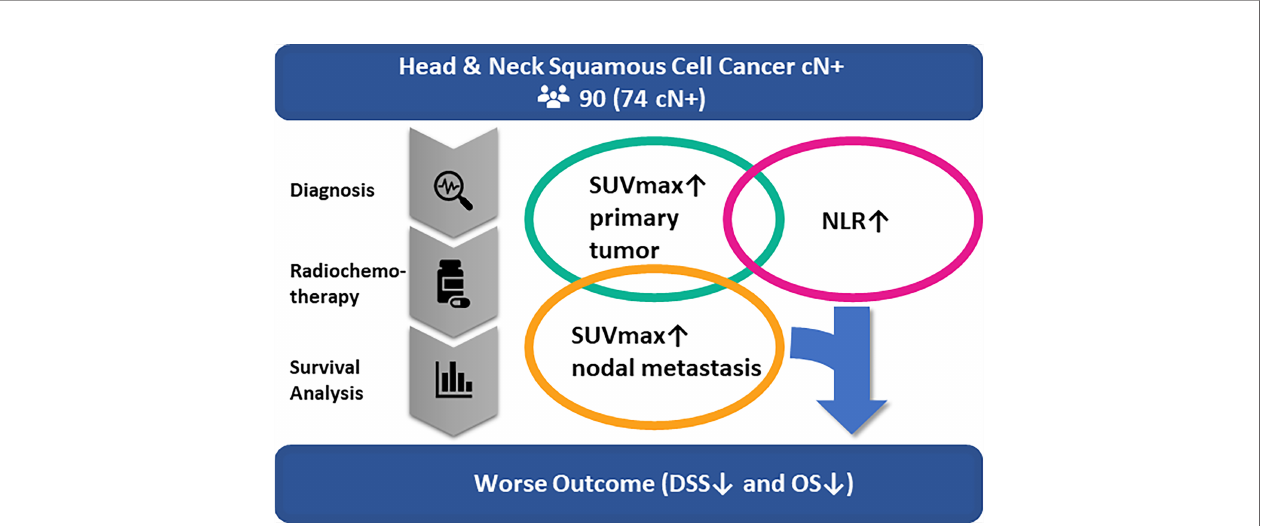
FIGURE 5 | Multivariate analysis of our patient cohort of nodal positive head and neck cancer patients undergoing primary chemoradiation shows that the NLR and SUV max of nodal metastasis are predictive of disease-speci fi c survival and overall survival. There was a signi fi cant correlation between NLR and SUV max of the primary tumor but not between NLR and nodal SUV max . Therefore, the NLR and SUV max of nodal metastasis could be used in addition to the TNM-classi fi cation to improve survival prediction and support treatment decision making in nodal positive head and neck cancer